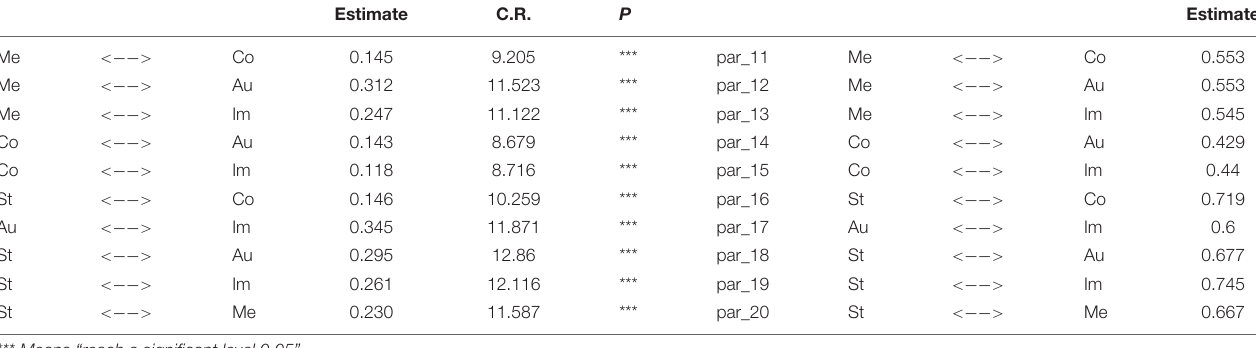
TABLE 10 | Covariances and correlations (group number 1 – default model).